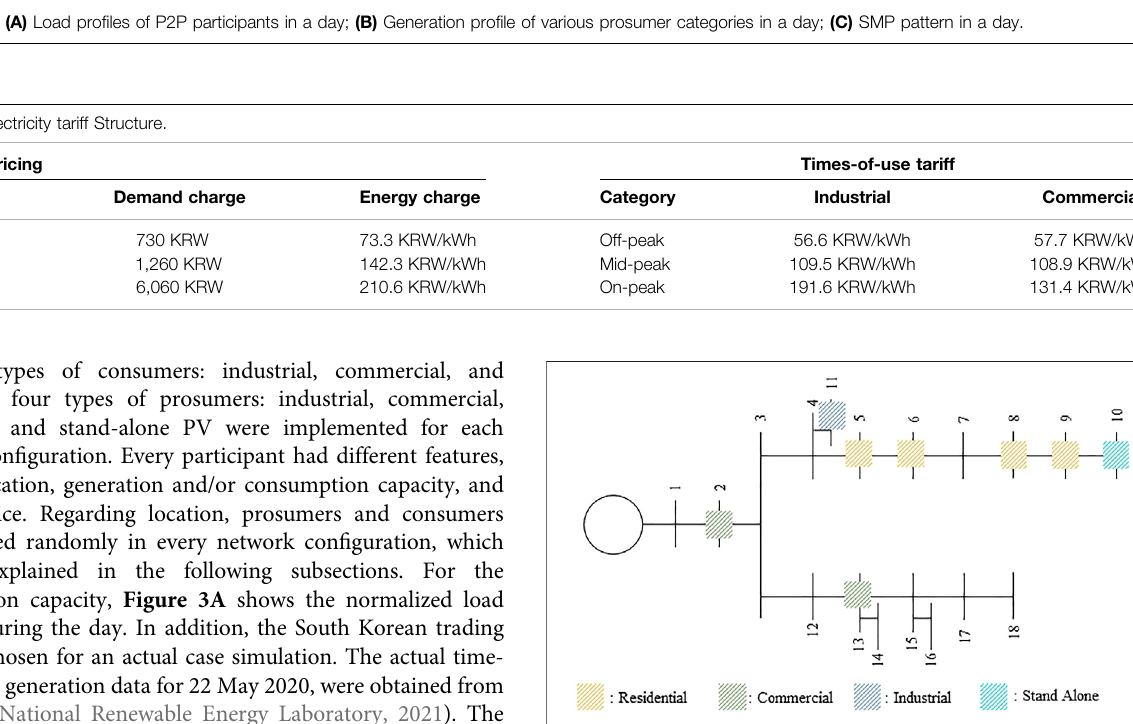
FIGURE 4 | Con fi guration of 18-bus distribution system with